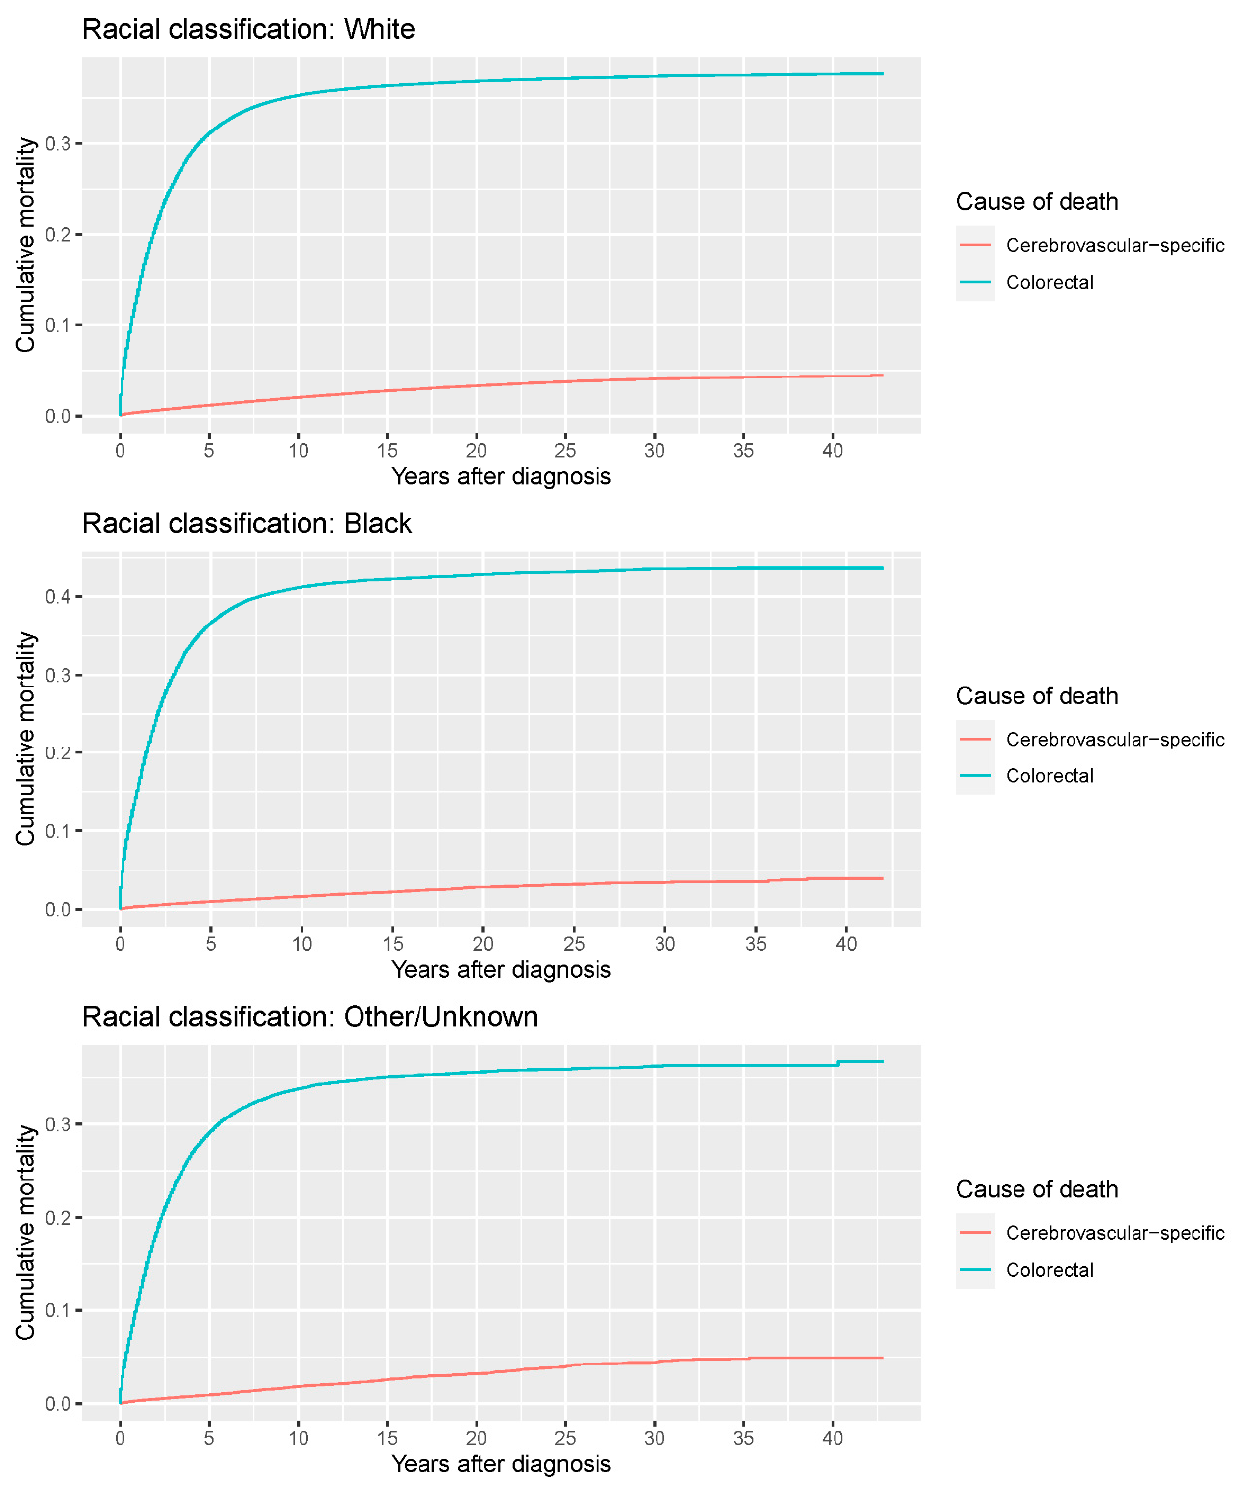
Figure 9. Cumulative cerebrovascular-specific and colorectal cancer-specific mortality stratified by race. Univariate analyses using a competing risk model were performed to test the relationship between race and CVSM in CRC patients ( p < 0.0001), and differences in cumulative mortality among different subgroups were analyzed by Gary’s test.